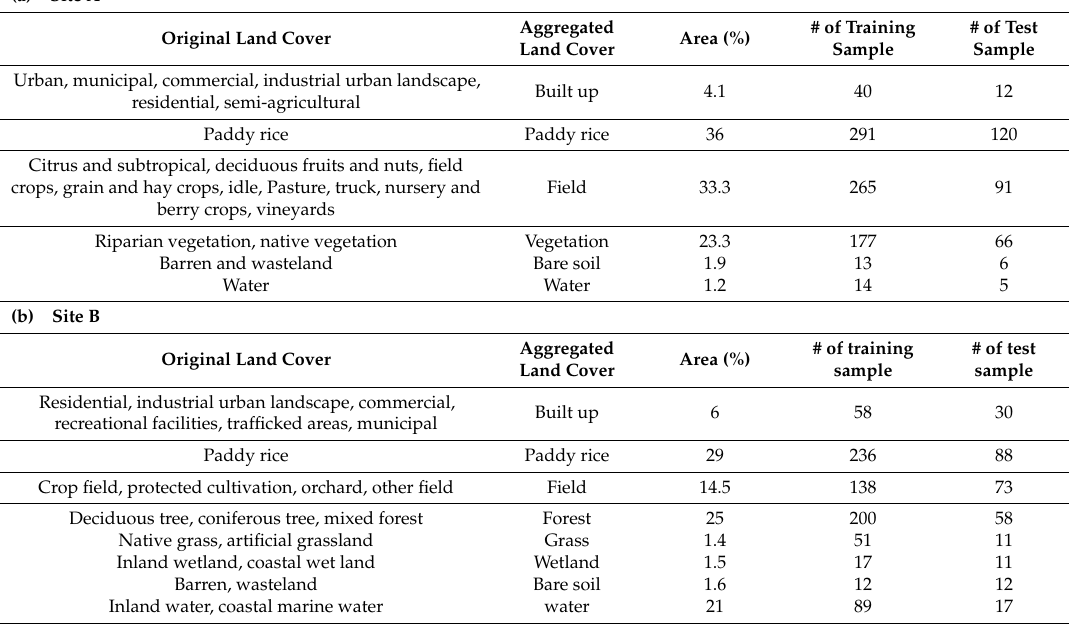
Table 3. The original land cover, aggregated land cover, the number of samples (1100), and the percentage of area for each class.